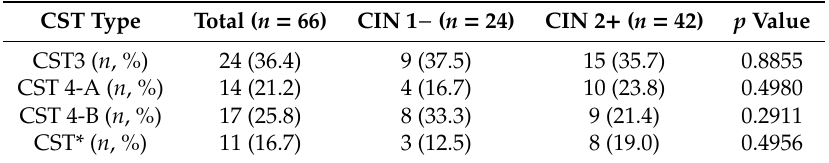
Table 2. CSTs according to the severity of cervical intraepithelial neoplasia